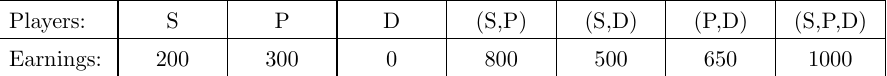
The players’ payroll in the jazz band